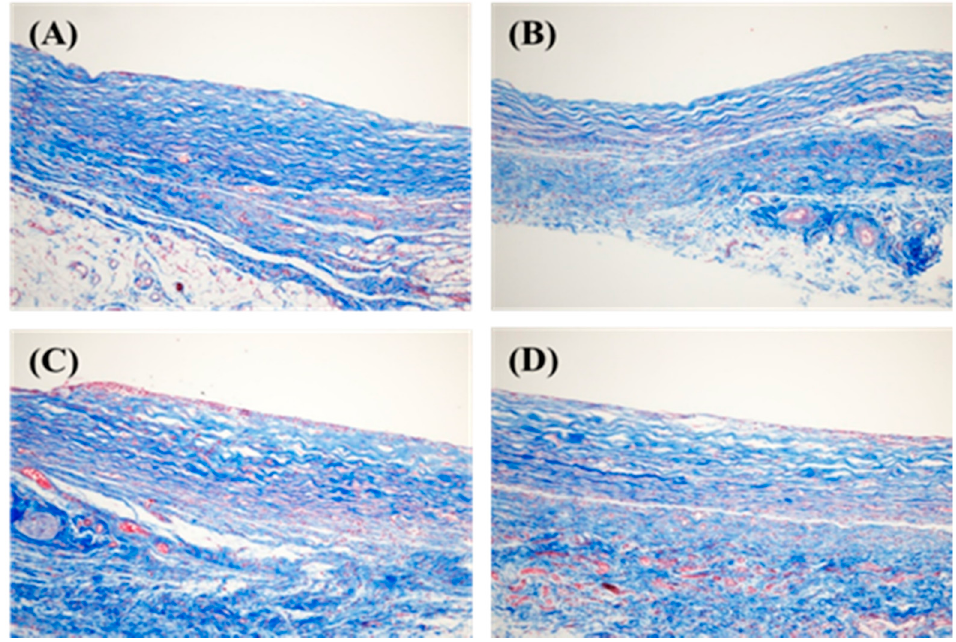
Figure 11. Arrangement of collagen fiber stained with Masson’s trichrome (200× magnification). ( A ) Bare (control), ( B ) 7:3, ( C ) 5:5, and ( D ) 3:7 groups.